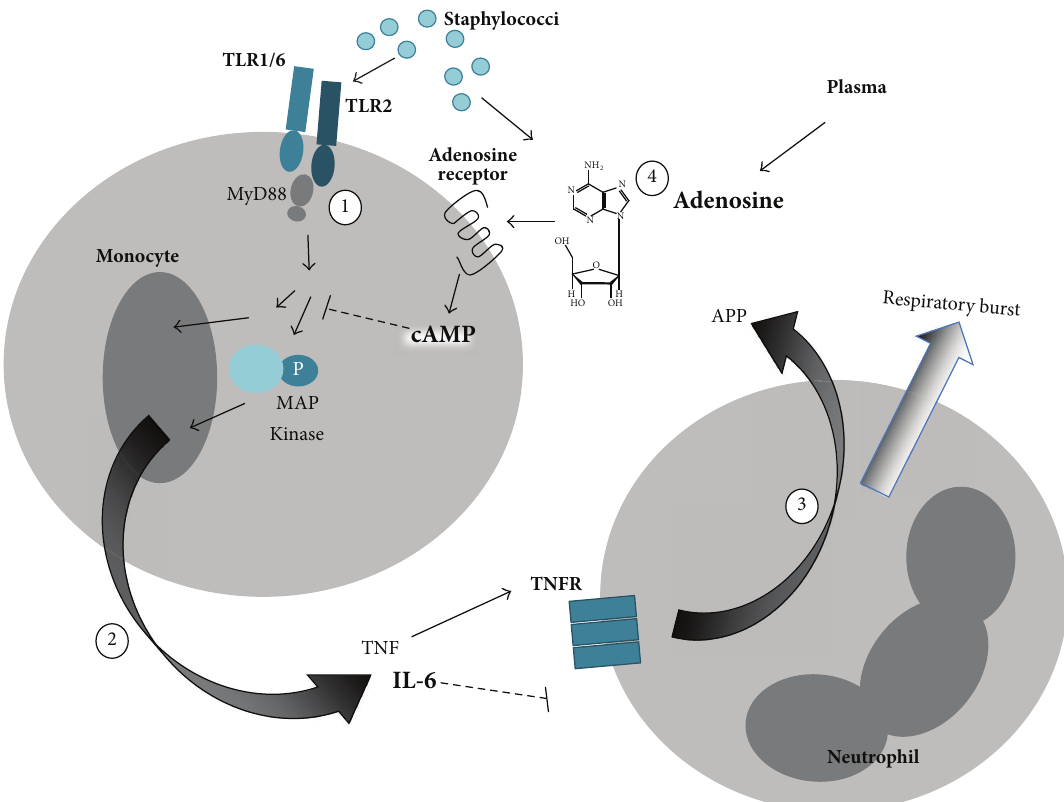
Figure 1: Sensor and effector function of neonatal innate immune system to Staphylococci spp. (1) Monocytes detect Staphylococci through TLR2 and (2) result in TLR-mediated production of proinflammatory cytokines such as TNF, and (3) TNF activates neutrophils to produce oxygen radicals and release APPs. (4) Both endogenous plasma and Staphylococcus -derived adenosine inhibit pro-inflammatory innate immune responses. Newborn monocytes are deficient in MyD88, activation of MAP kinases, and in TLR-mediated TNF but do produce robust amounts of IL-6, a proresolution cytokine that inhibits neutrophil migration. Overall, this pattern of response impairs neutrophil activation and migration and secretion of APPs. Deficiencies in neonatal responses to staphylococci are depicted by smaller font size, whereas agents that are elevated in newborns are indicated with a larger and bolded